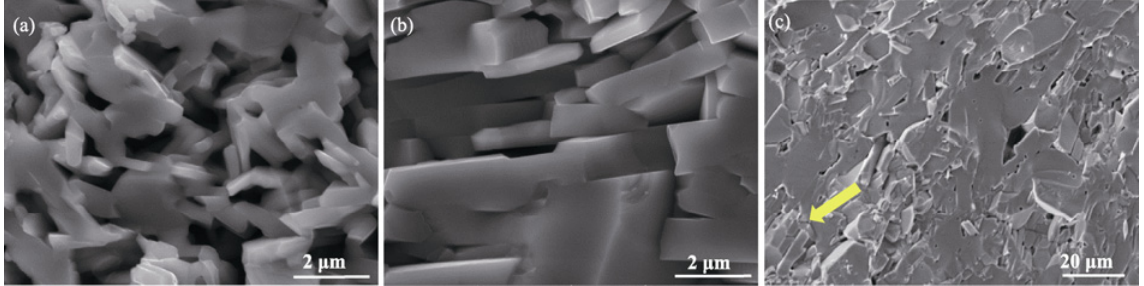
Fig. 6 Typical SEM images detected on cross sections of fractured specimens at T s = (a) 1100 ℃ , (b) 1150 ℃ , and (c) 1250 ℃